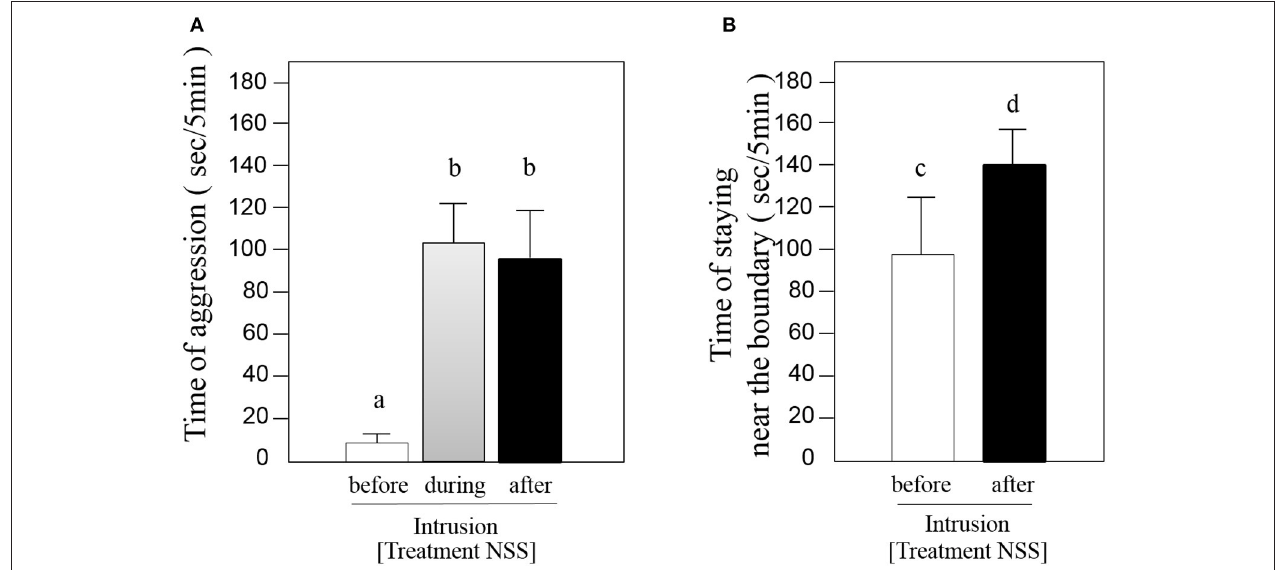
FIGURE 4 | Results of Treatment NSS. (A) Average duration ( ± SE, n = 6) of aggressive behavior by the focal fish against a dear neighbor (open bar), introduced stranger (gray bar) and the stranger after being shifted into neighbor’s territory from the small plastic case (solid bar). (B) Average duration ( ± SE, n = 6) of time spent at the boundary by the focal fish against dear neighbor (open bar) and the stranger after being shifted into neighbor’s territory (solid bar). The different letters above the bars denote differences at P < 0.01.